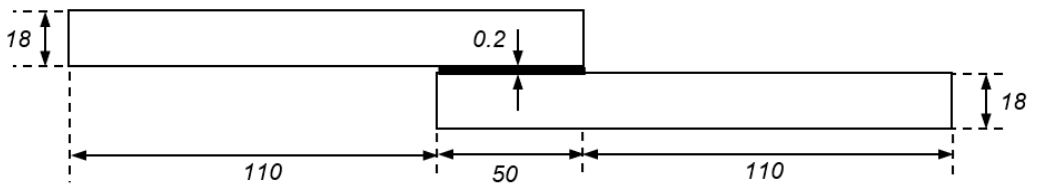
Figure 2. Specimen geometry for single lap-shear adhesive joint (dimensions in mm). Specimen breadth, b = 25 mm.